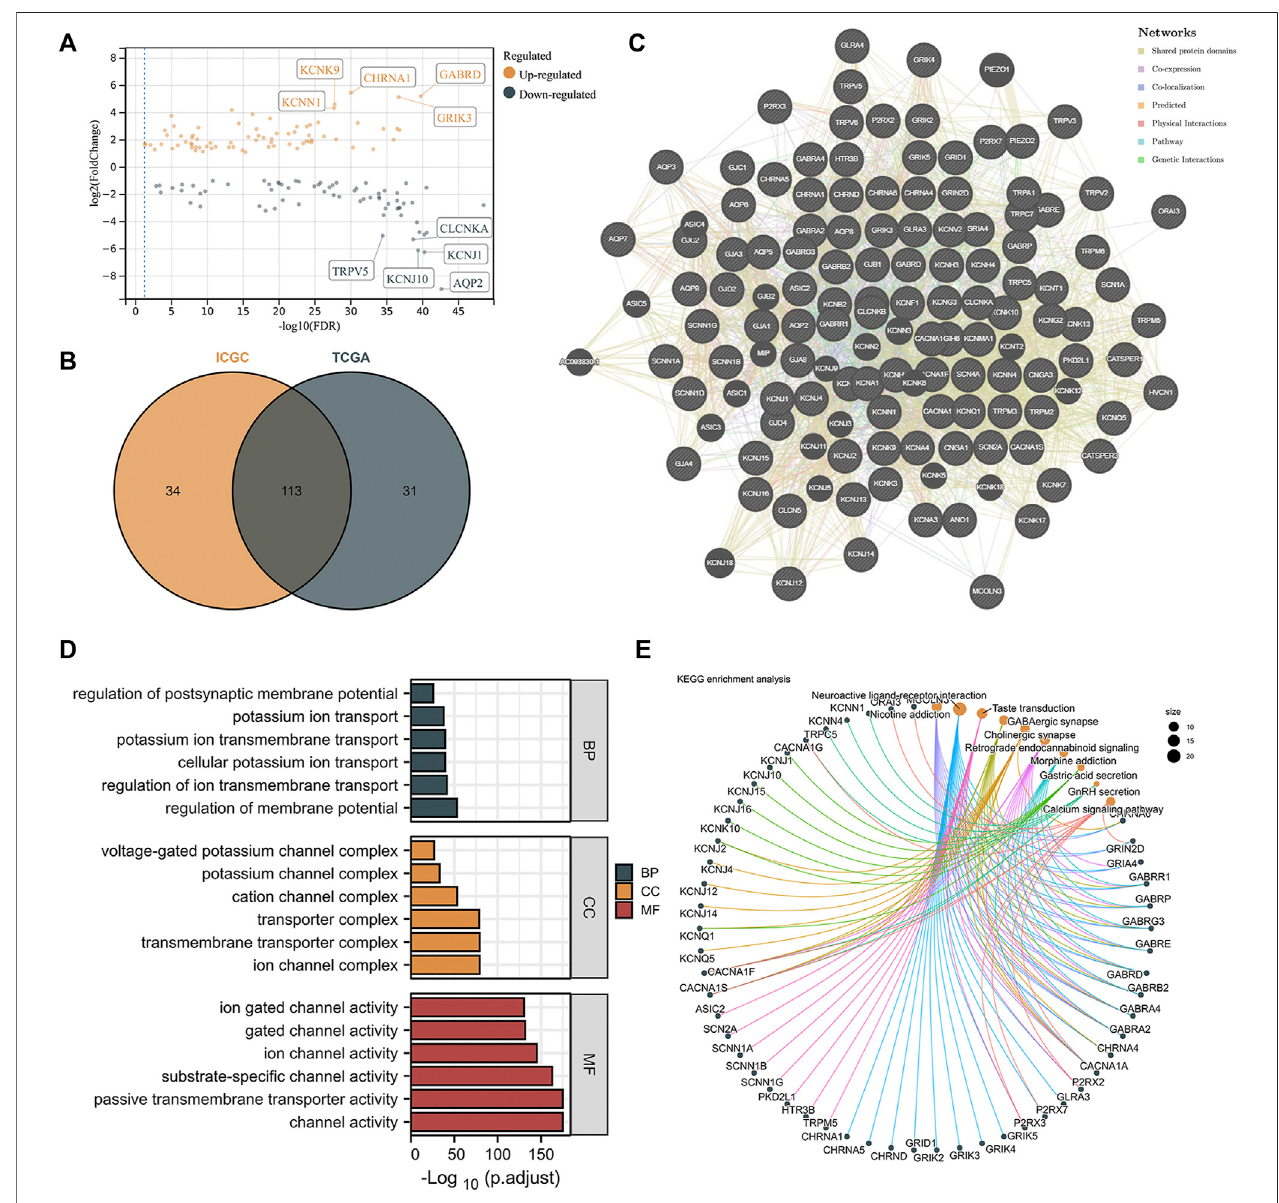
FIGURE 2 | Identi fi cation and functional enrichment of differentiallyexpressed ICRGs. (A) Volcano map on differentially expressed ICRGs in TCGA cohort. The fi ve most signi fi cant up- and downregulated genes were labeled separately. (B) VENN plots of the same differential genes in ICGC and TCGA databases. (C) PPI network created by GeneMANIA showing the interactions of the ICRGs. (D) Bar plot for GO pathways in TCGA cohort (the longer bar means the more signi fi cantly enrichment). (E) Circle diagram of the KEGG pathway analysis (larger pathway point size indicates more IRCGs are included).